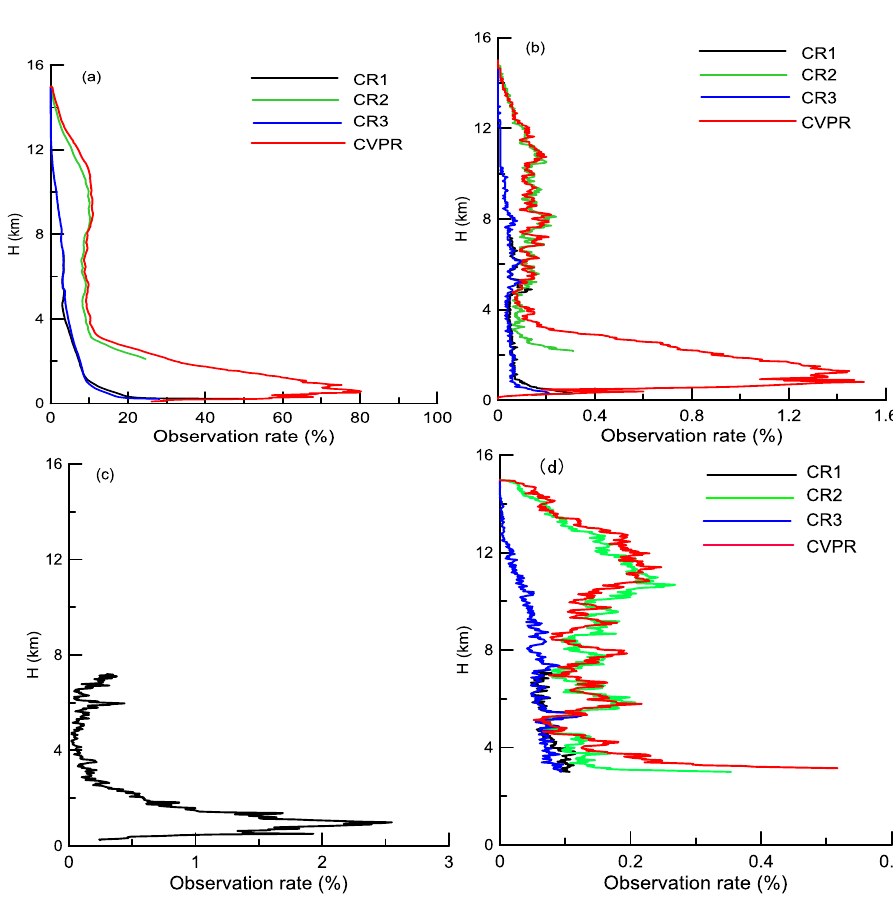
Figure 8. Valid observation rates of ( a ) valid reflectivity; ( b ) echo bases by radars and ( c ) cloud bases by CEIL and ( d ) echo tops at different altitude.